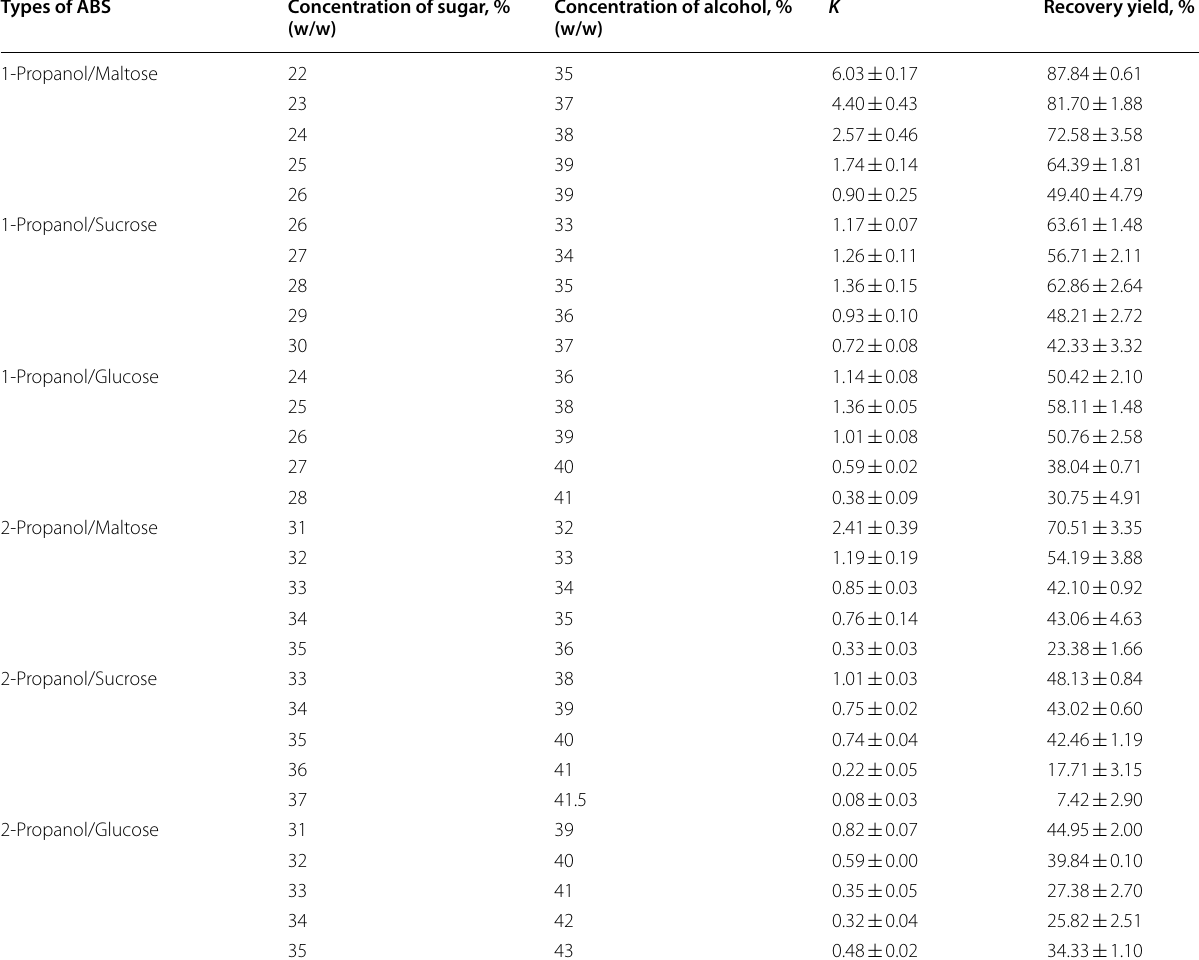
Table 1 Effect of types and concentration of phase-forming components on the partition efficiency of BSA with propanol/sugar